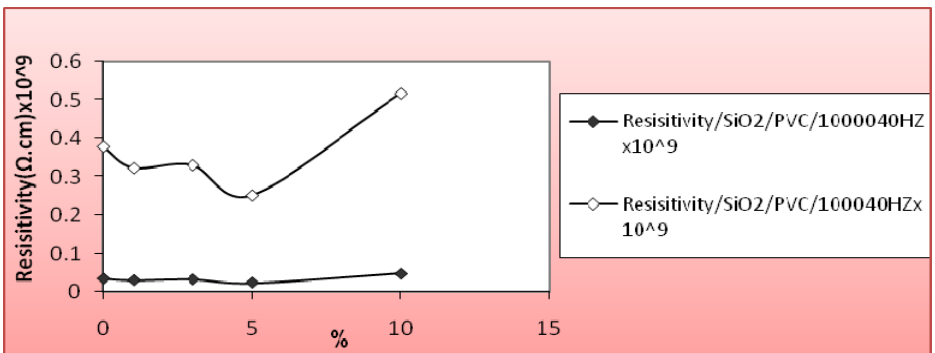
Fig.16: Frequency dependent resistivity of SiO